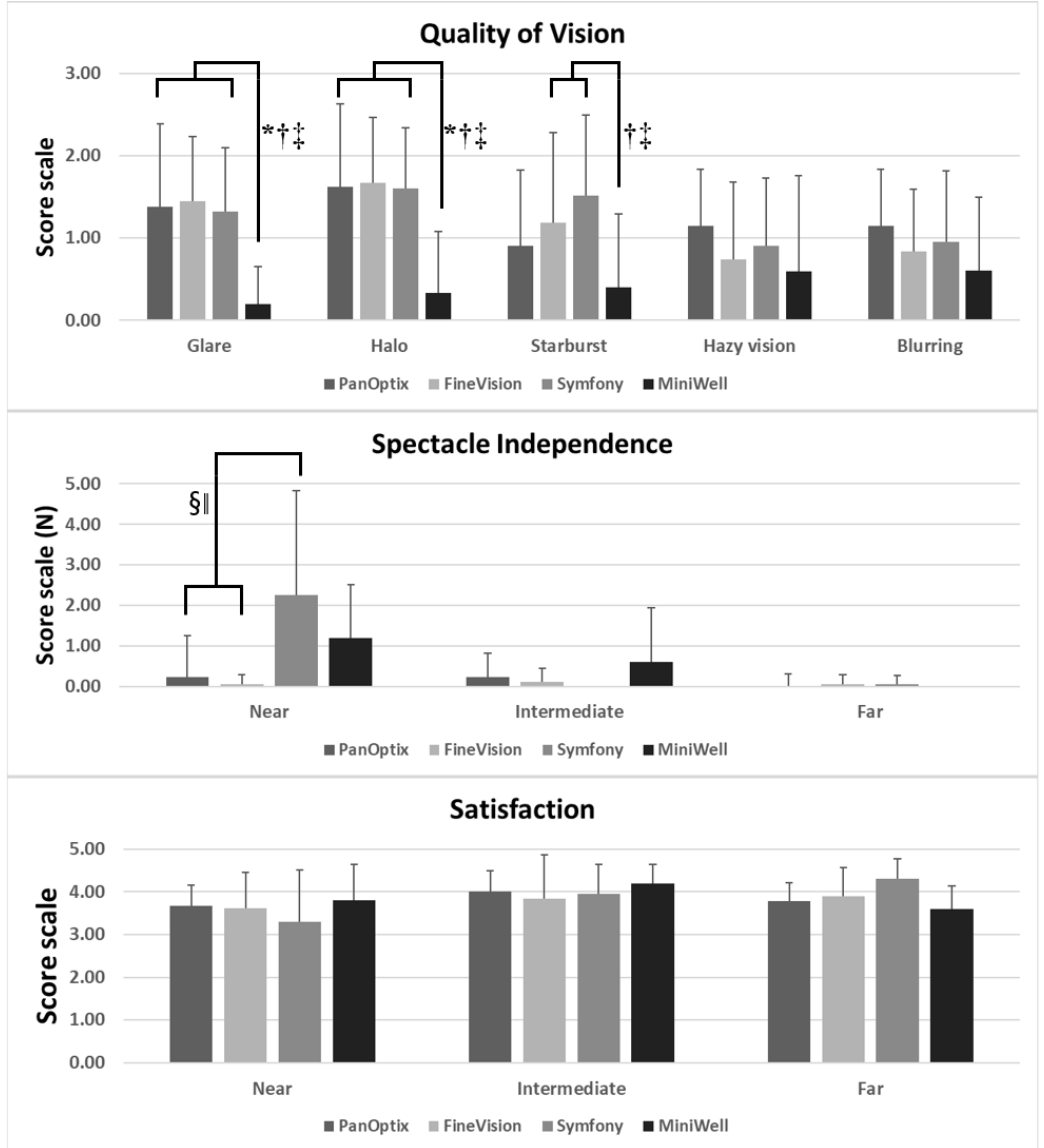
Figure 4. Subjective symptoms experienced with PanOptix, FineVision, Symfony, and MiniWell, as reported in the questionnaire (quality of vision, spectacle independency, and overall satisfaction). ( Top ) MiniWell presented with less glare, halo, and starburst compared with the other three intraocular lenses. ( p = 0.004 for glare, p = 0.002 for halo, p = 0.027 for starburst by Kruskal–Wallis test). ( Middle ) Symfony presented with the greatest spectacle dependency at near distance, followed by MiniWell ( p = 0.001 by Kruskal–Wallis test). ( Bottom ) All four intraocular lenses in the study presented with comparable overall satisfaction for near, intermediate, and far vision. Spectacle dependence score scale: 0–10 (0 = none; N = N out of 10; 10 = Always). Quality of vision score scale: 0–3 (0 = none; 1 = mild; 2 = moderate; 3 = severe). Subjective satisfaction score scale: 1–5 (1 = very unsatisfied; 2 = unsatisfied; 3 = neither satisfied nor dissatisfied; 4 = satisfied; 5 = very satisfied). Error bar indicates standard deviation. Footnotes indicate statistically significant differences among the four groups: (*: PanOptix vs. MiniWell, †: FineVision vs. MiniWell, ‡: Symfony vs. MiniWell, §: PanOptix vs. Symfony, (cid:107) : FineVision vs. Symfony. Post hoc power analyses results are described in Supplemental Table